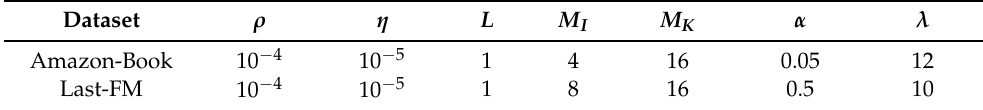
Table 3. Hyper-parameter settings of CKER.